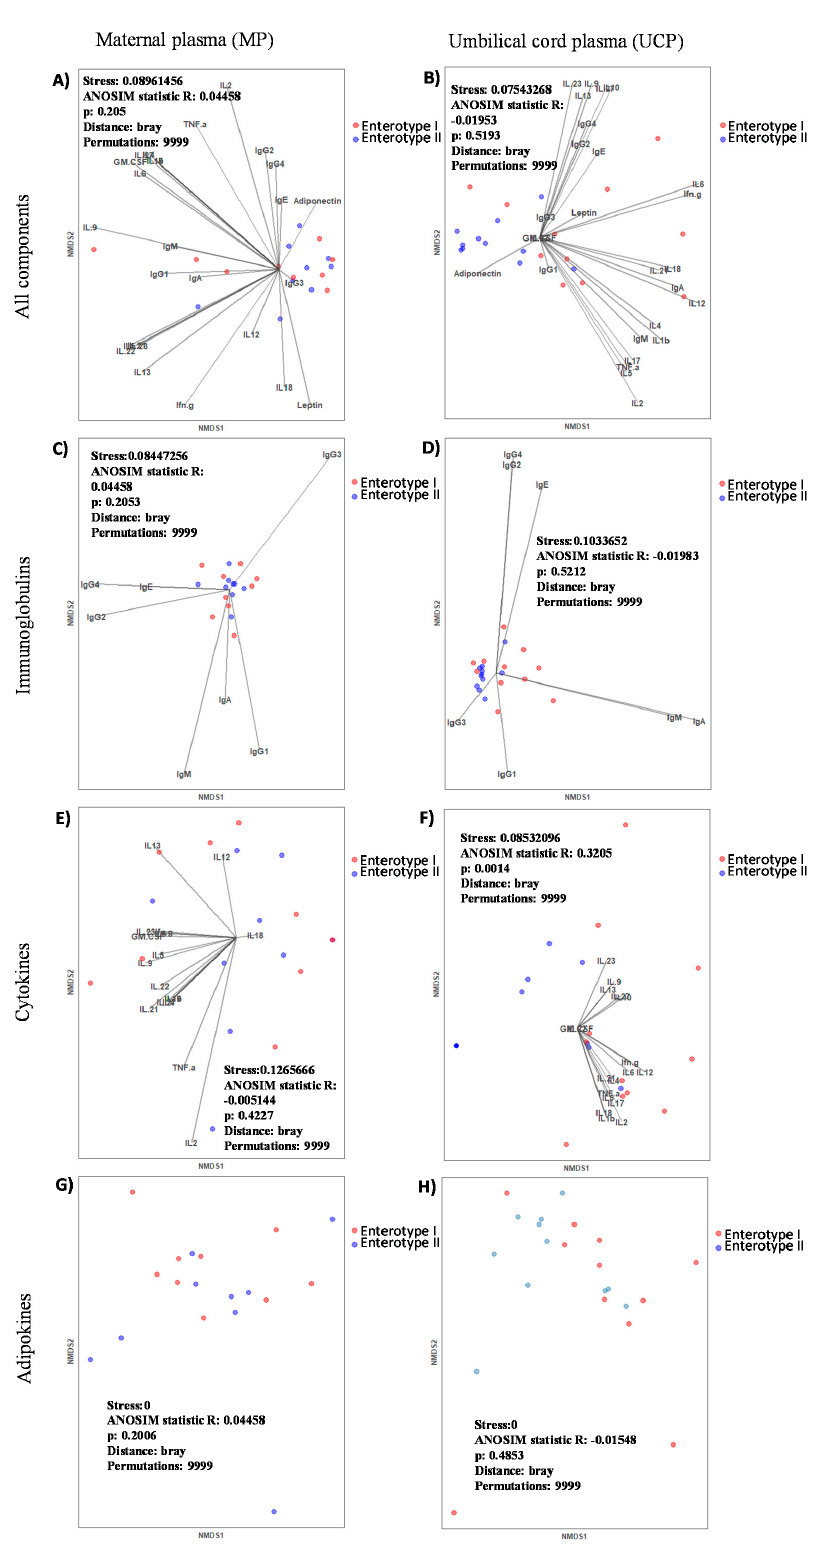
Figure 4. Non-metric multi-dimensional scaling (NMDS) representations of the immune compo- nents studied with regard to maternal enterotype in maternal plasma ( A , C , E , G ) and umbilical cord plasma ( B , D , F , H ) showing all components ( A , B ): Igs alone ( C , D ), CKs alone ( E , F ), and adipokines alone ( G , H